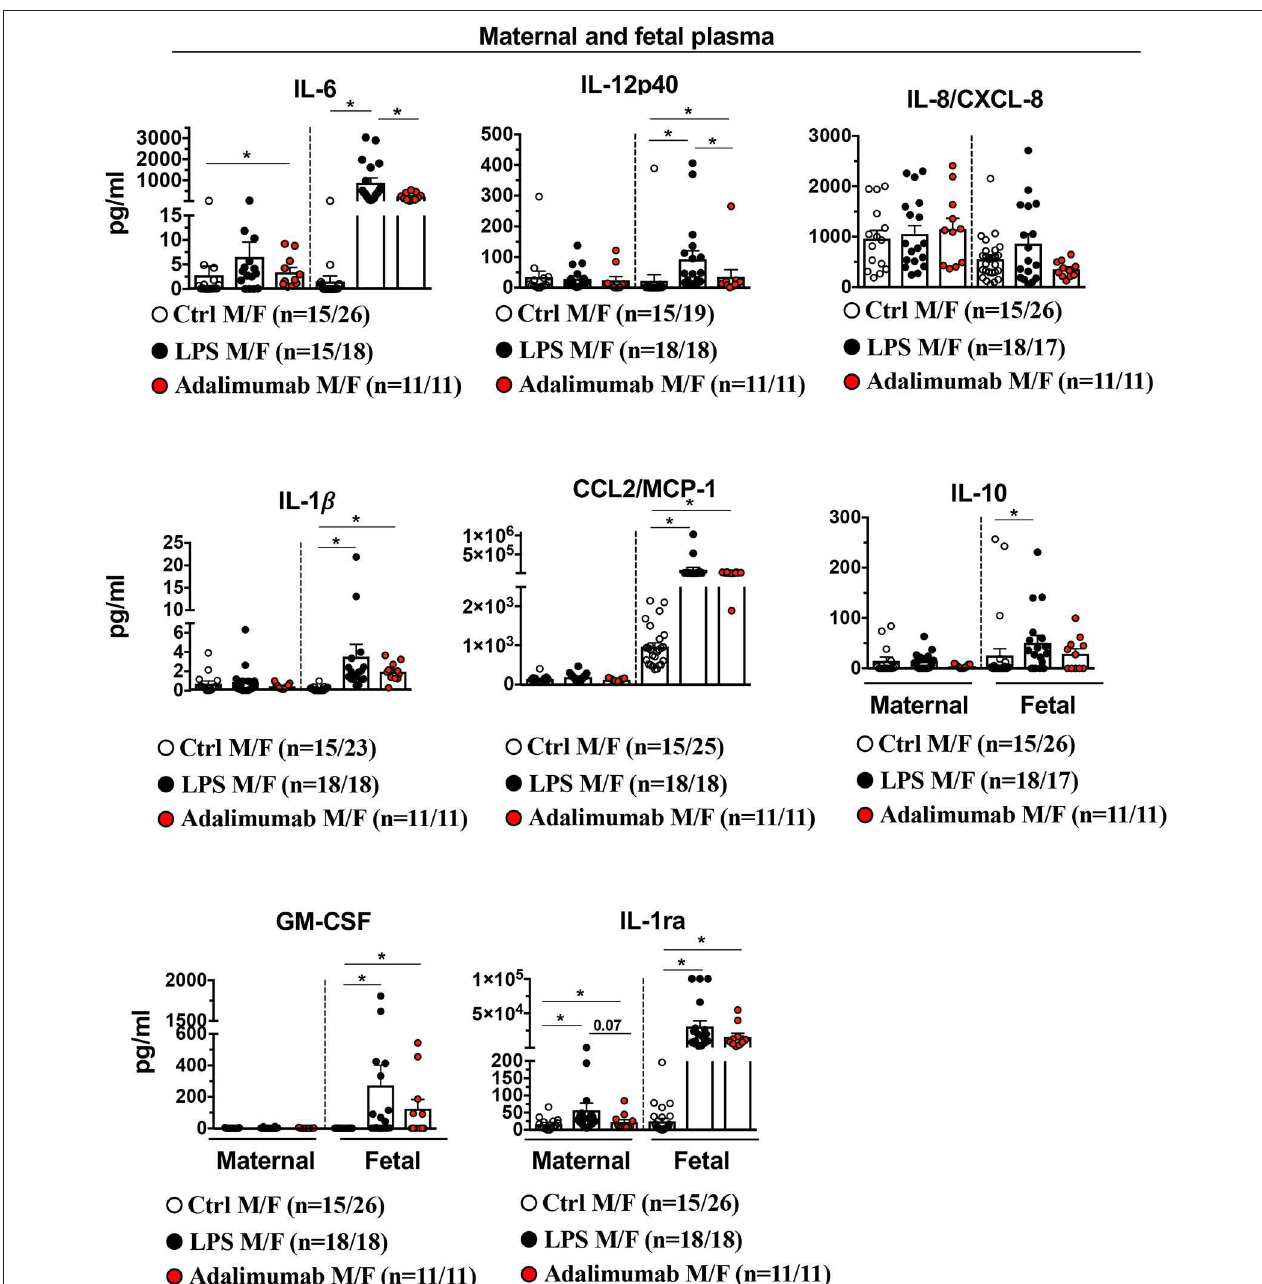
FIGURE 8 | Adalimumab decreased partially inflammation in fetal plasma. Cytokine concentrations were measured in maternal and fetal plasma by multiplex ELISA. There was a minimal increase in cytokines in maternal plasma after IA LPS. In the fetal plasma, Adalimumab significantly decreased LPS-induced IL-6, and IL12p40, but not IL-8/CXCL8, IL-1 β , CCL2/MCP1, IL10, GM-CSF, and IL-1ra (Maternal plasma: Ctrl n = 15; LPS n = 15–18; Adalimumab n = 11; Fetal plasma: Ctrl n = 19–26; LPS n = 17–18; Adalimumab n = 11). M, Maternal; F, Fetal. Data are mean ± SEM, * p < 0.05 between comparators by Mann-Whitney U -test.